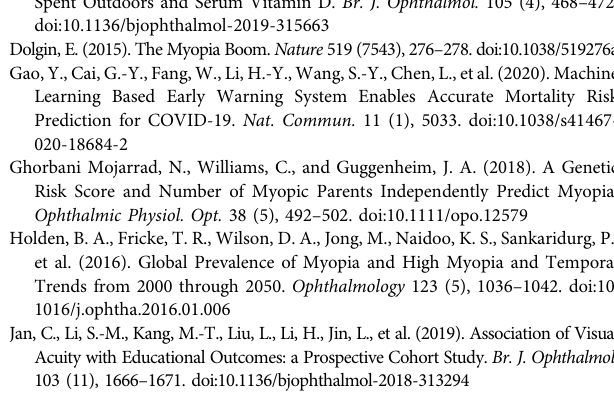
Supplementary Figure S1 | Feature selection by LASSO. (A) The cross- validation curve (red dotted line) along with upper and lower standard deviation curves along the λ sequence (error bars) in the myopia prediction model. Two special values along the λ sequence are indicated by the vertical dotted lines. The left line is the value of λ that gives minimum mean cross- validated error, while the right line is the value of λ that gives the most regularized model such that the cross-validated error is within one standard error of the minimum. (B) LASSO variable trace pro fi les of features whose intracohort missing rates were less than 5% in the myopia prediction model. (C) The cross-validation curve along with upper and lower standard deviation curves along the λ sequence in the high myopia prediction model. (D) LASSO variable trace pro fi les of features whose intracohort missing rates were less than 5% in the high myopia prediction model. (E) Feature coef fi cient of LASSO with the best lambda value in the myopia prediction model. Positive coef fi cient and negative coef fi cient features are colored in red and blue, respectively. Gray features with coef fi cient 0 were considered redundant and removed. (F) Feature coef fi cient of LASSO with the best lambda value in the high myopia prediction model. SupplementaryFigureS2| Distributionofhighmyopiainchildrenandadolescents with different myopia occurrence times. (A) Myopia onset at age of ≤ 6 years. (B) Myopia onset at age of primary school. (C) Myopia onset at age of junior or senior high school. Supplementary Figure S3 | Height distribution of myopia population at different ages. (A) Height distribution of boys aged from 6 to 18 years. Green represents emmetropia, and red represents myopia. The vertical line represents the mean height, and the curve represents the probability density of the height distribution. (B) Height distribution of girls aged from 6 to 18